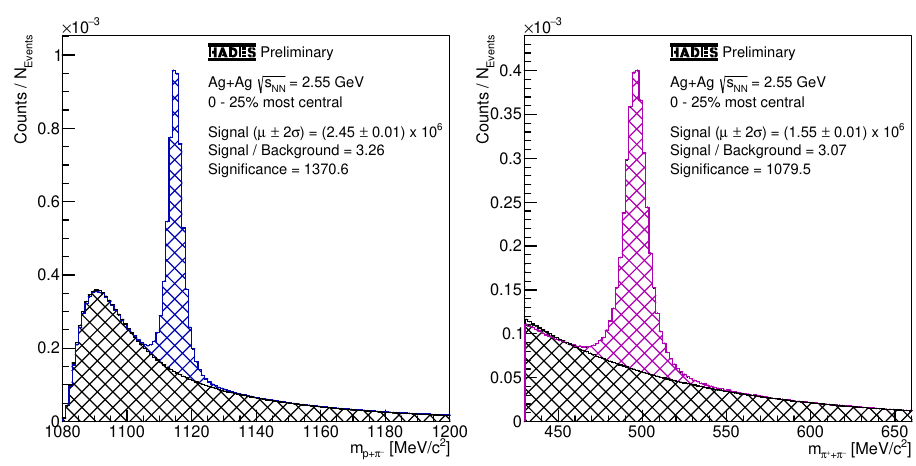
Figure 2. Invariant mass spectra of Λ → p + π – decays (left) and K 0 S → π + + π – decays (right) from the 0-25% most central Ag(1.58A GeV) + Ag events measured by